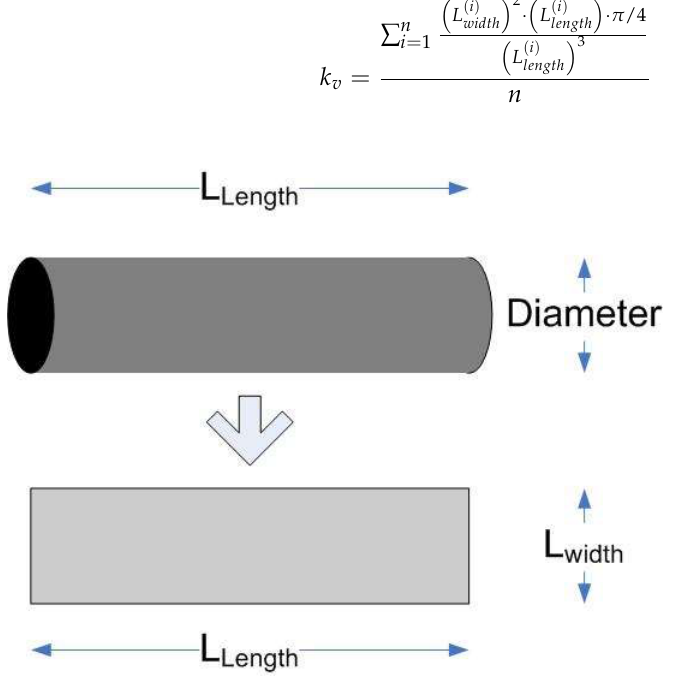
Figure 1. Projection of a cylinder onto the 2D-plane.